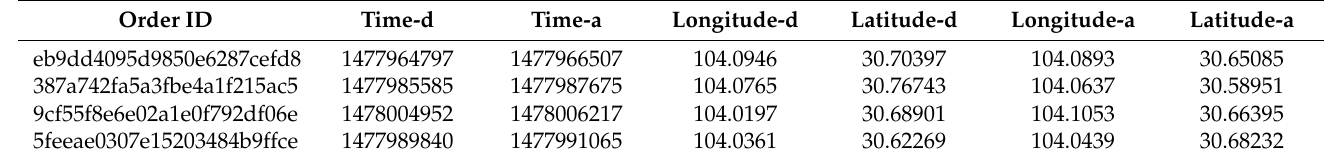
Table 1. Description of the ride-hailing dataset used in this